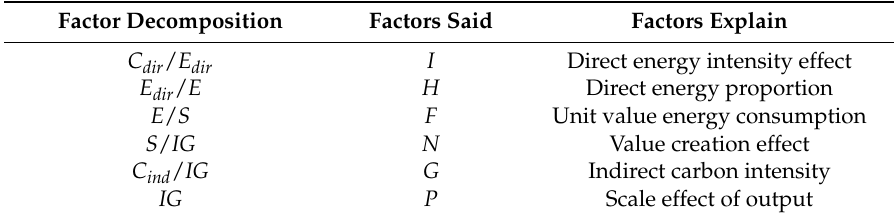
Table 1. Various factors